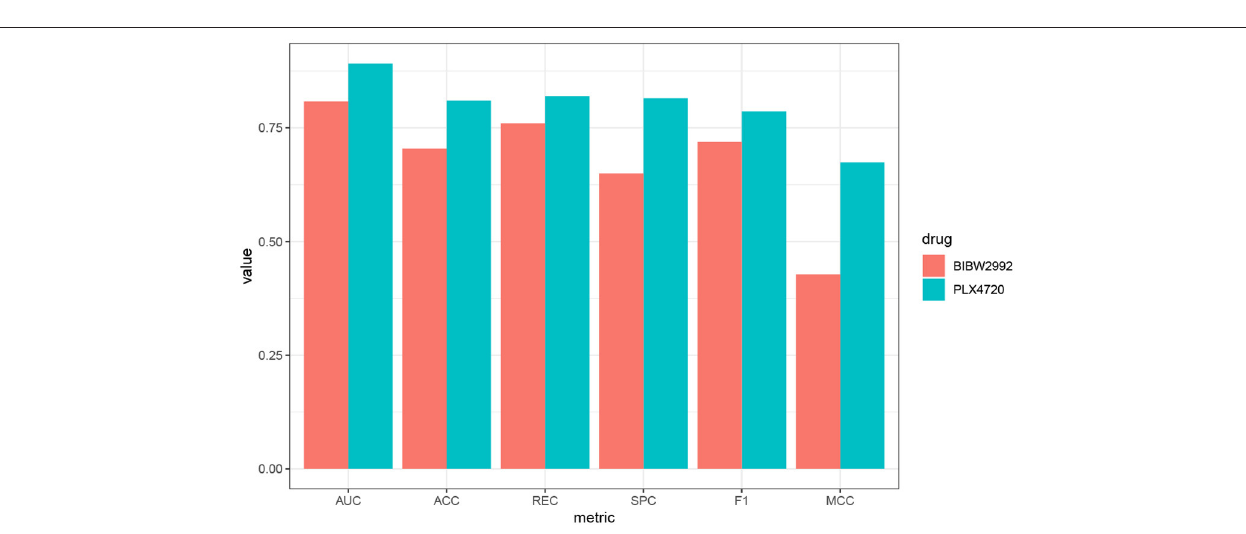
LRRC8E, SCG2, PHF8, PCSK1, ANXA2 , and MIR6730 .